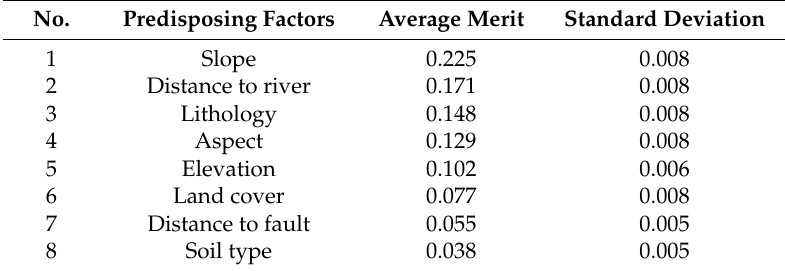
Table 1. Predictive ability of eight landslide predisposing factors using Pearson technique and 10-fold cross validation